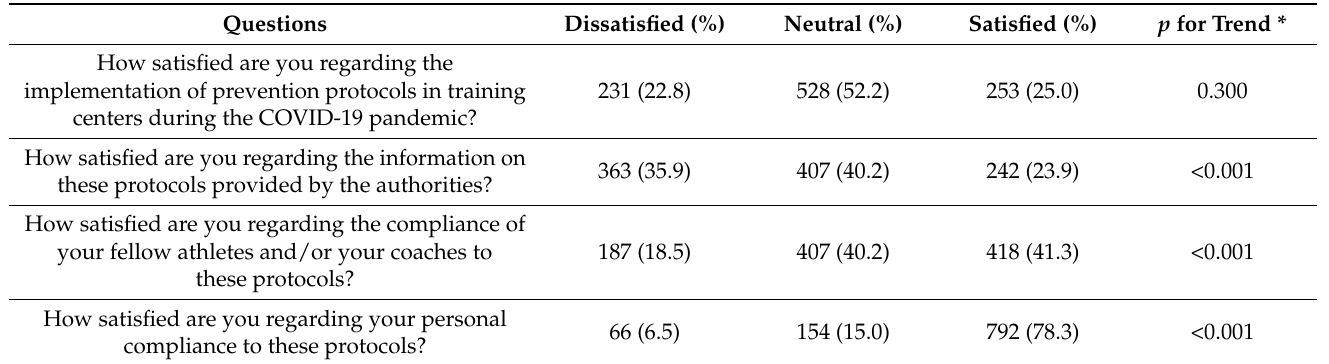
Table 4. Level of athletes’ satisfaction regarding different aspects of prevention protocols imple- mented in training